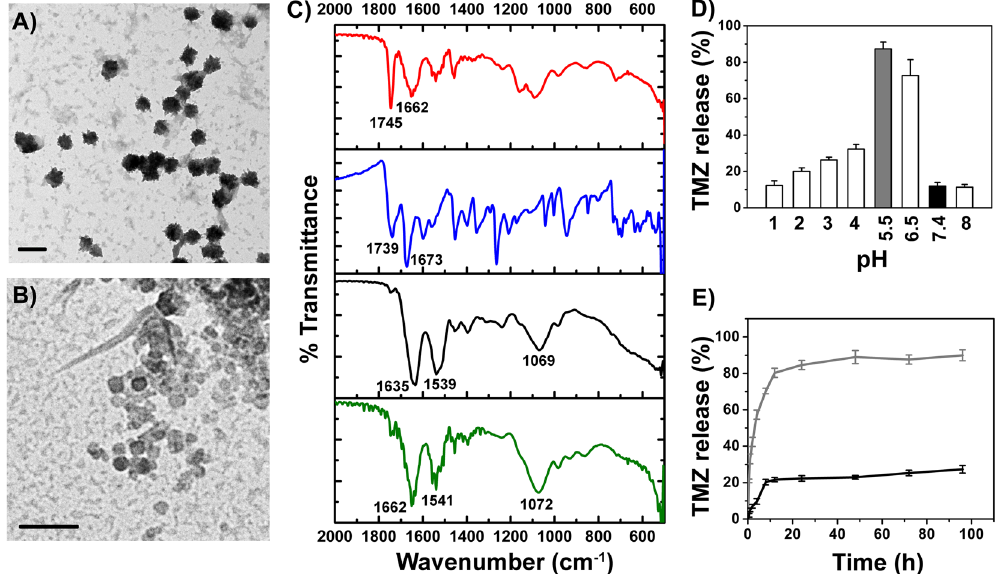
Figure 1. TEM analysis of particles incubated at (A) pH 7.4 and (B) pH 5.5 (scale bar 200 nm). (C) FT-IR spectra of free Lf (black), LfNPs (green), TMZ (blue) and TMZ-LfNPs (red). (D) Release of TMZ from LfNPs studied at different pH values. pH 5.5 and pH 7.4 are highlighted in grey and black respectively. (E) Cumulative TMZ release from LfNPs at pH 5.5 (grey) and pH 7.4 (black). Each data points were repeated in triplicates (n = 3) and presented as Mean ± Standard Deviation